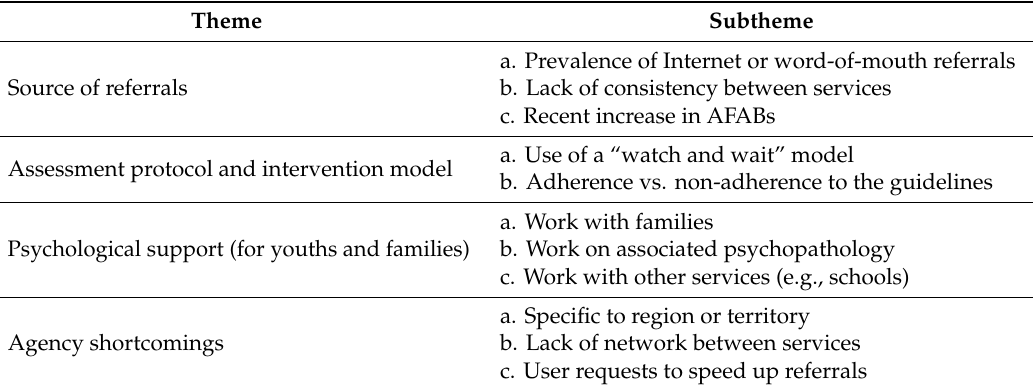
Table 1. Interview themes and